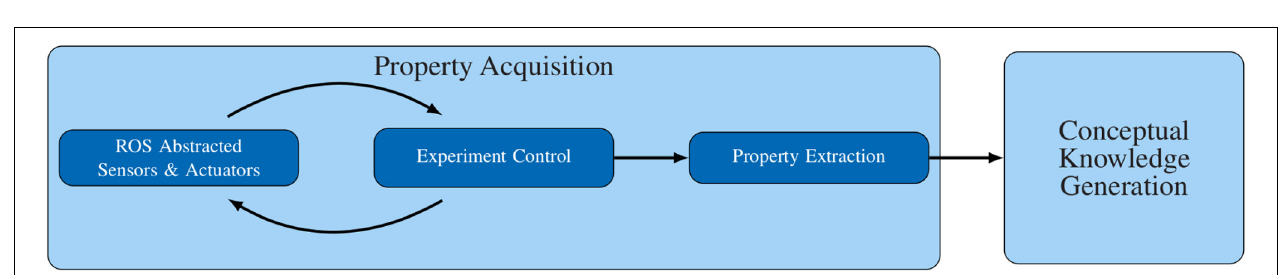
FIGURE 6 | The robot-centric conceptual knowledge generation process is illustrated where acquired continuous property data of objects { o 1 , o 2 ... } is sub-categorized into multiple clusters. Using Bi-variate joint frequency distribution and sample proportions conceptual knowledge about object classes (e.g., plasti_box ) is generated.